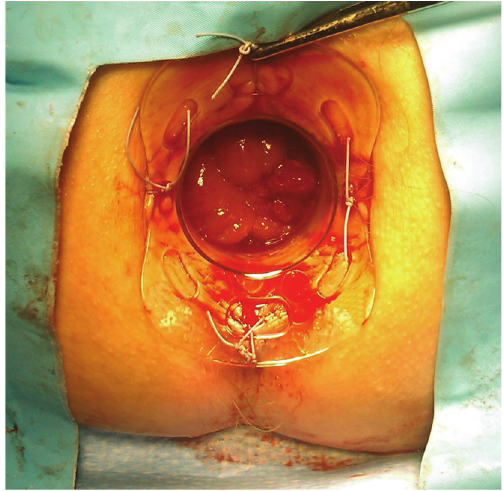
Figure 1: The disposable anal retractor is well fixed with four skin stitches.